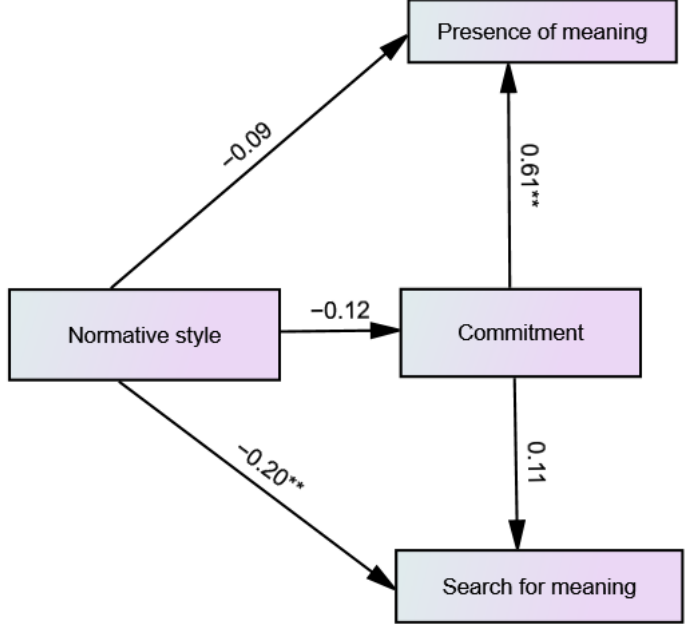
Figure 2. Path diagram of the predictive relationships between normative identity style, commitment, presence of meaning and search for meaning, including the standardized path coefficients. ** p <